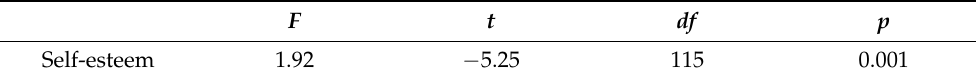
Table 2. The results of the analysis with the use of the Student t -test of patients before and after the procedure for the variable: own body assessment.